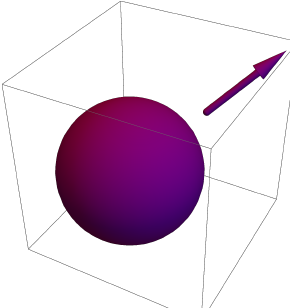
Figure 1. Representation of the corresponding geometry. The sphere represents the expanding dark fluid, and the arrow the radial